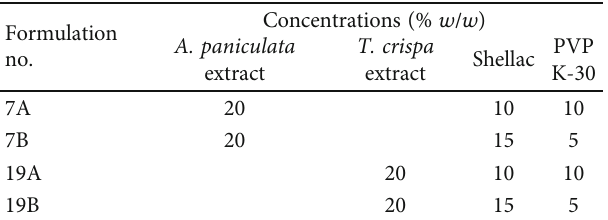
Table 3: Composition of developed nail lacquers containing bitter extract and